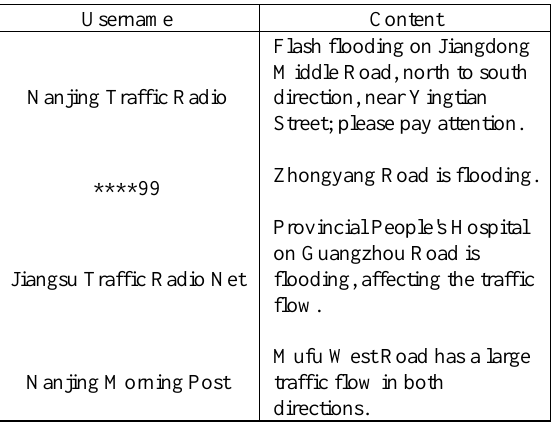
Table 4 . Example of Weibo data details